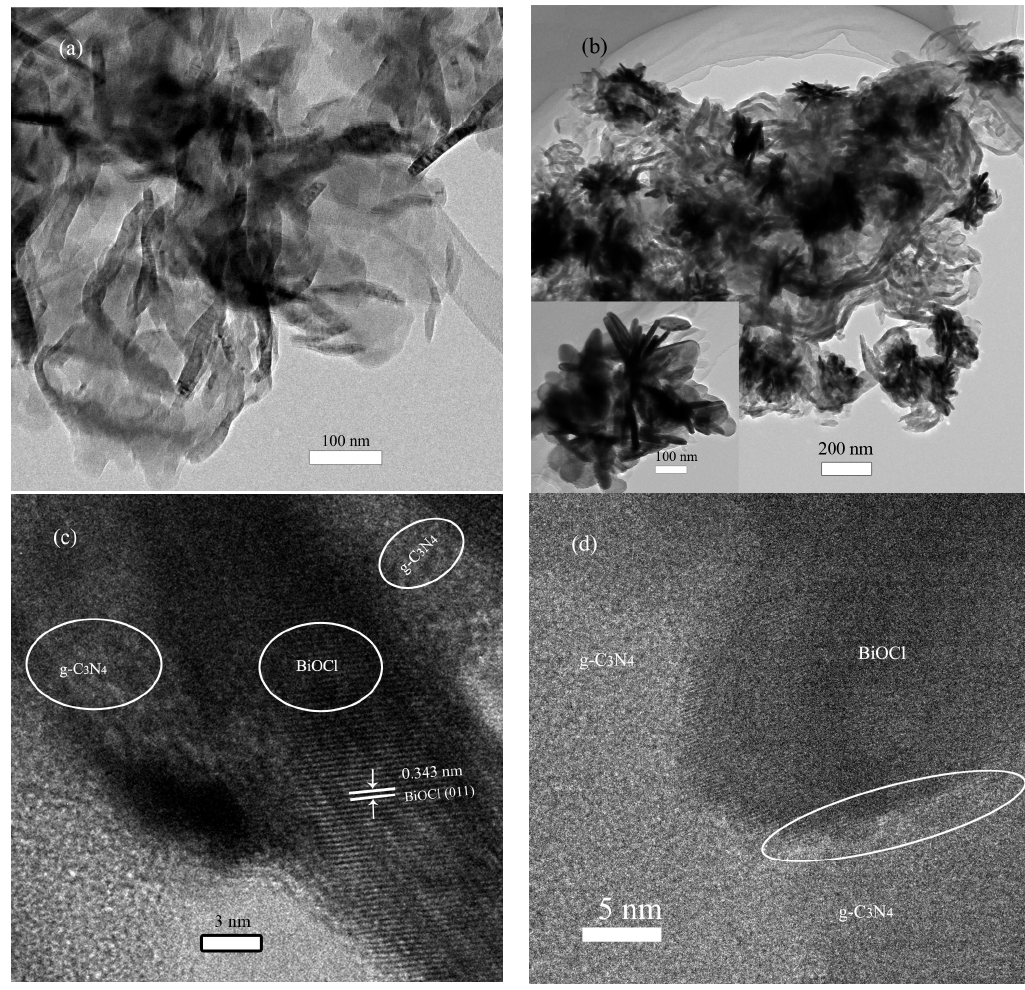
Figure 4. ( a ) TEM image of the as-obtained g-C 3 N 4 sample; ( b ) TEM image of N 0.45 B 0.55 sample; and ( c , d ) HRTEM images of N 0.45 B 0.55 sample